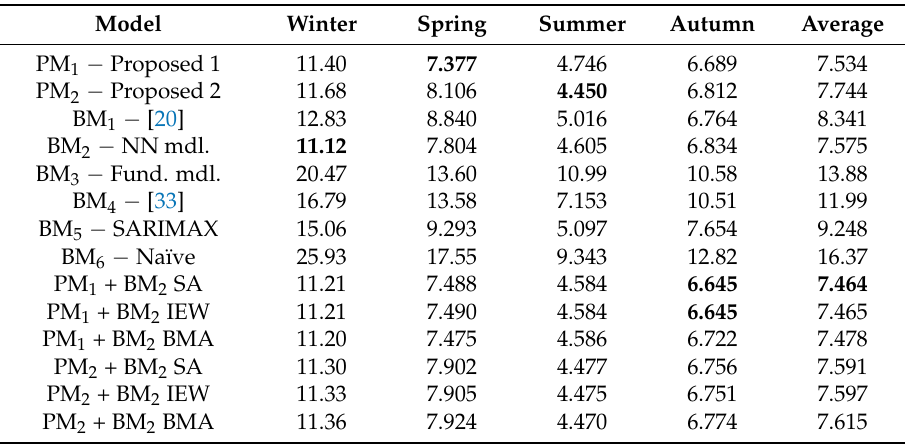
Table 3. Forecasting error in terms of MAPE